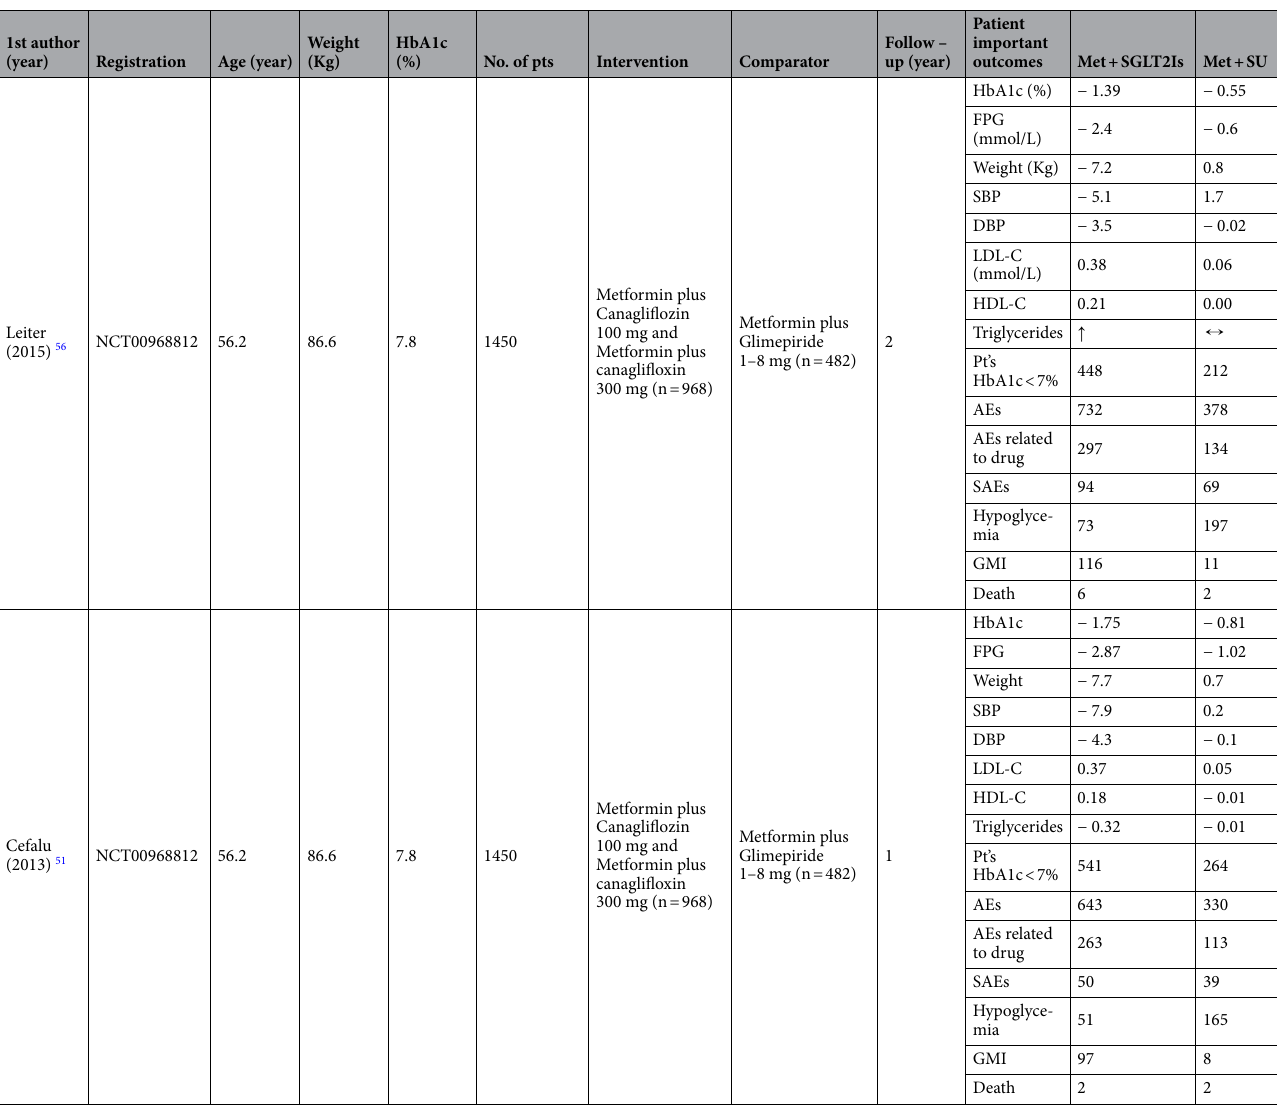
Table 1. Characteristics of included RCTs. AEs adverse events, AMI acute myocardial infraction, CAD coronary artery disease, CAO coronary artery occlusion, CV cardiovascular, HbA1c hemoglobin A1c,